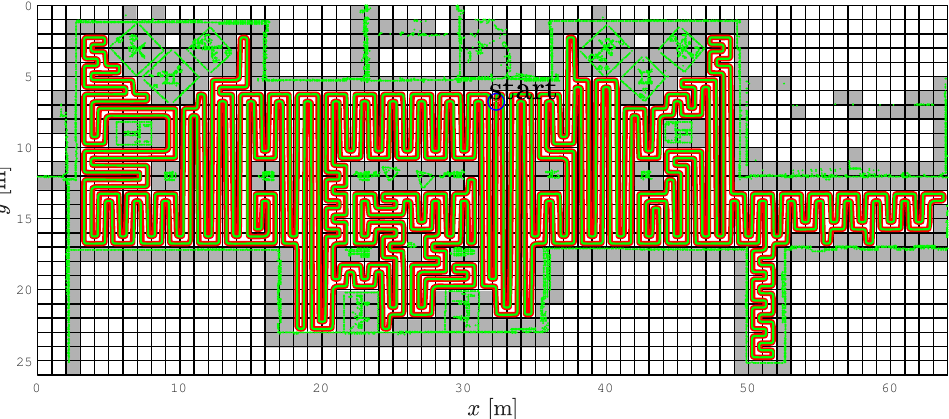
Figure 10. The SCCPP algorithm in the Aula scenario , which presents the smoothed path with red line and the executed path with green line.